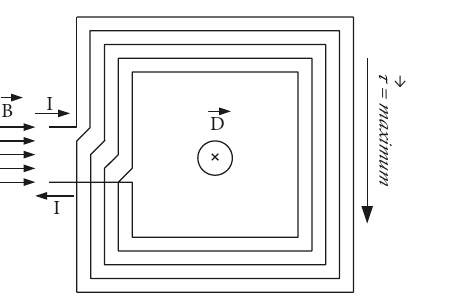
Figure 20: Current-carrying coil in presence of magnetic fi